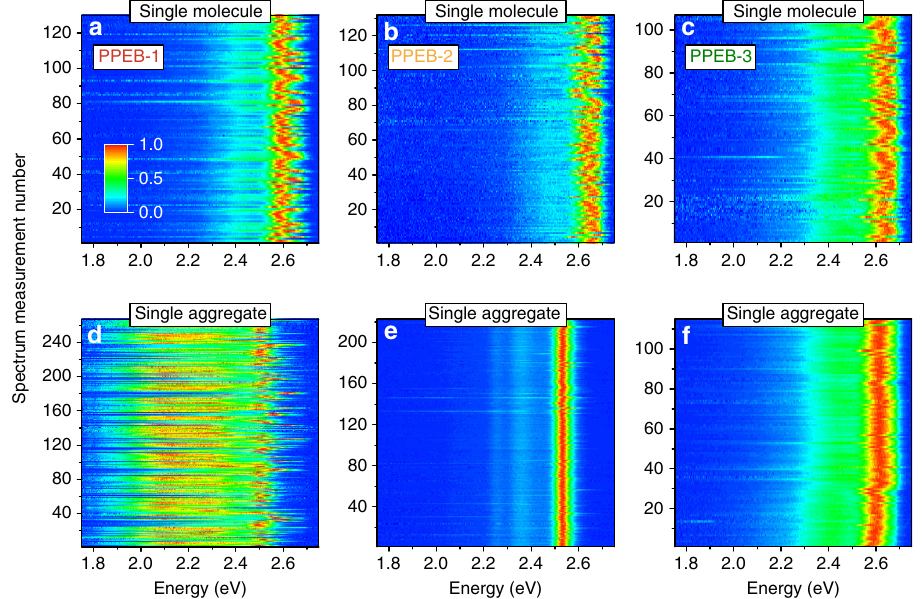
Fig. 3 Comparison of single-molecule and single-aggregate spectra. a – c Normalized single-molecule spectra plotted on a false-color intensity scale of PPEB-1 a , PPEB-2 b , and PPEB-3 c . d – f Single-aggregate spectra of PPEB-1 d , PPEB-2 e , and PPEB-3 f . Aggregates were grown by in situ SVA, subsequently dried under nitrogen and measured in air